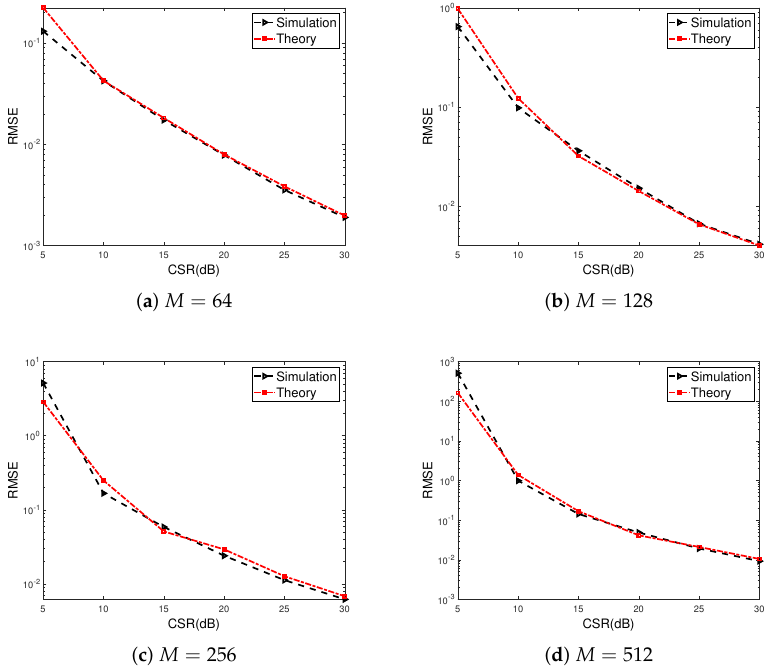
Figure 4. Gain-phase error estimation performance results of the proposed for large-scale ULAs versus CSRs, SNR = 40dB, K 0 = 20, T = 80, N =